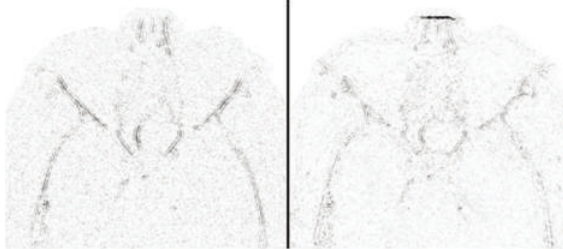
Figure 12: Head reconstruction errors with respect to the reference image (darker shade corresponds to a larger error). Left: PWLS, right: our method (stage